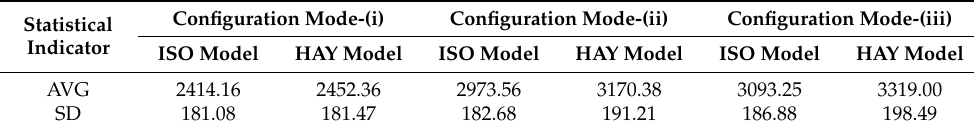
Table 1. Averages (AVG) and standard deviations (SD) of the ISO- and HAY-estimated annual solar energy sums across Saudi Arabia in the period 2005–2016 under all-sky conditions.